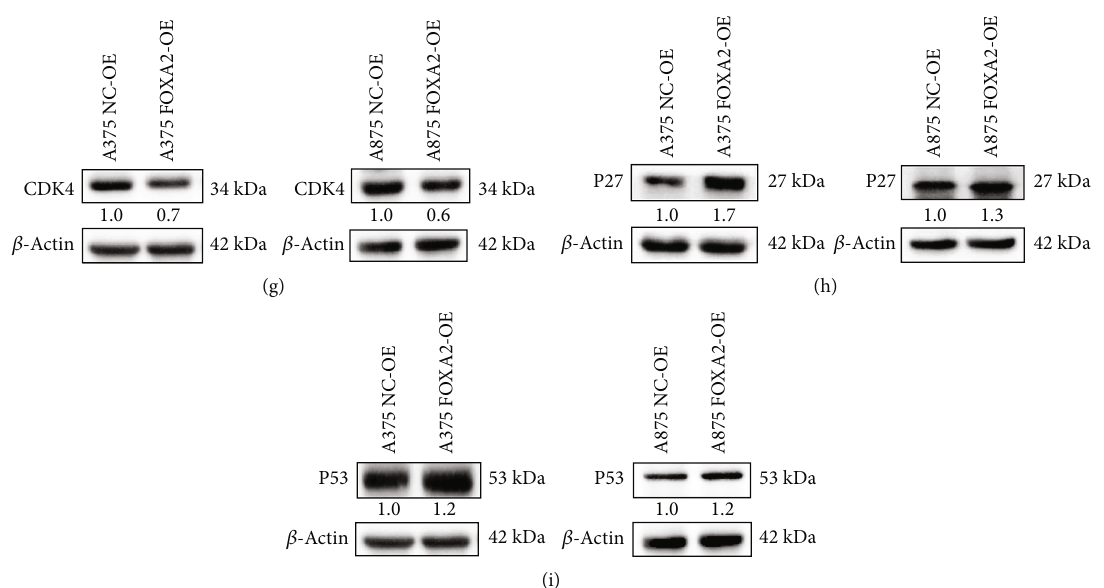
Figure 7: FOXA2 inhibits melanoma cell proliferation in vitro . (a) Cell growth curves of NC-OE and FOXA2-OE melanoma cells were plotted using MTT assays. (b) The proliferative capacity of NC-OE and FOXA2-OE melanoma cells was determined by plate clone formation assays. (c) Flow cytometry analysis of the cell cycle of NC-OE and FOXA2-OE melanoma cells. (d – f) RT-qPCR analysis of the relative mRNA expression of CDK2, CDK4, and cyclin D1 in NC-OE and FOXA2-OE melanoma cells. (g – i) Western blotting analysis of the protein expression of CDK4, P27, and P53 in NC-OE and FOXA2-OE melanoma cells. ∗ p < 0 : 05 , ∗∗ p < 0 : 01 , ∗∗∗ p < 0 : 001 , and ∗∗∗∗ p < 0 : 0001 vs. control cells.